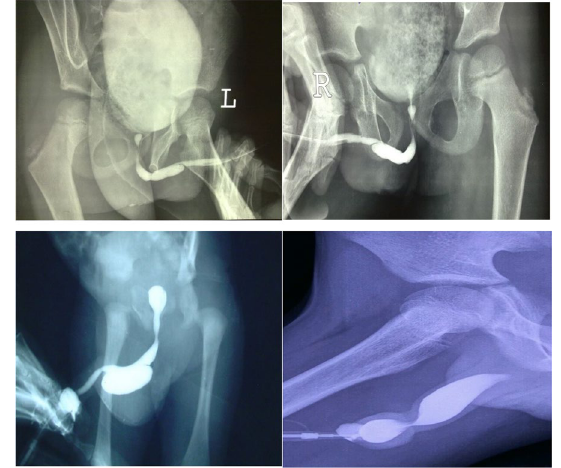
Fig. 1 RGU. a Case 1 with AUV. b Case 2 with AUV and small anterior urethral diverticulum. c Case 3 with large saccular anterior urethral diverticulum at the distal and mid urethra. d Case 5 with diffuse anterior urethral diverticulum